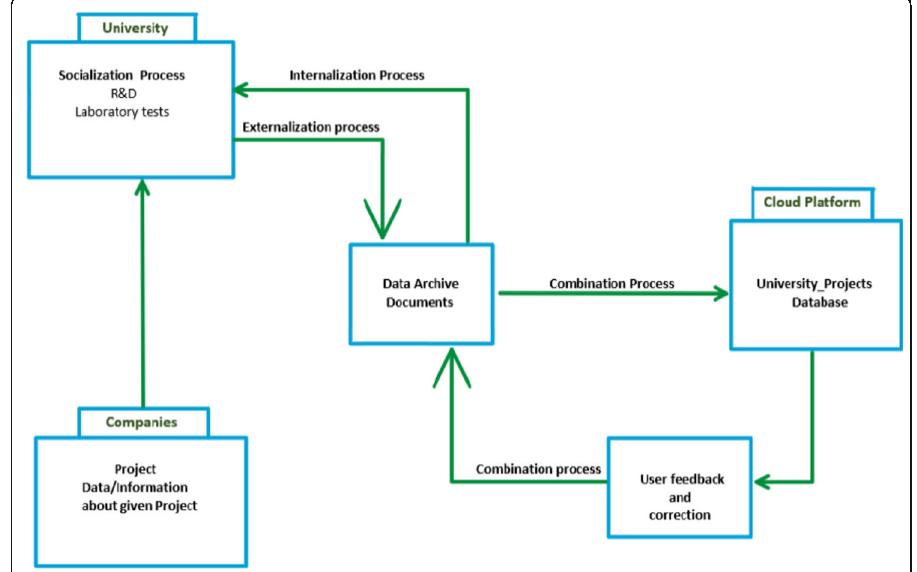
Fig. 4 The reinforcement of SECI model with the use of a